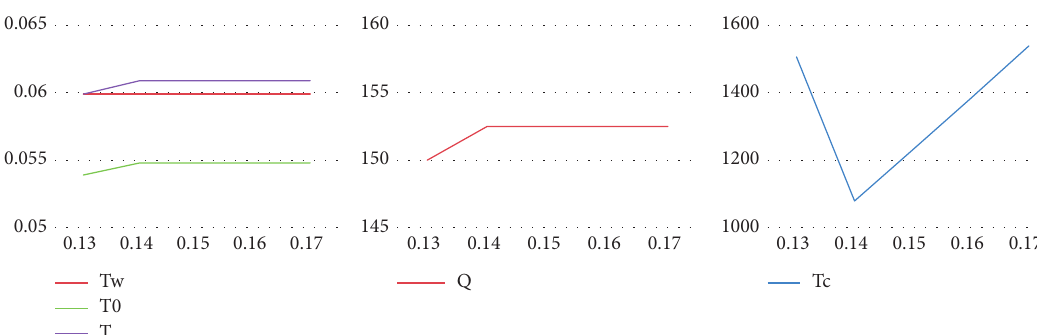
Figure 12: The effect of parameter N on decision variables.